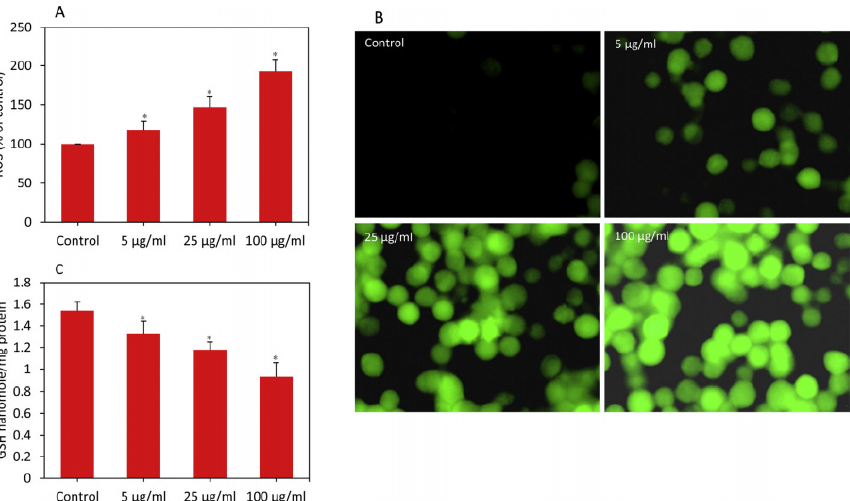
Figure 3. Copper ferrite NP-induced oxidative stress in MCF-7. Cells were exposed to copper ferrite NPs at the dosages of 0, 5, 25, and 100 g/mL for 24 h. At the end of exposure, ROS and GSH levels were determined, as described in materials and methods. ( A ) Percentage change in ROS level. ( B ) Fluorescence microscopy image of ROS generation. ( C ) GSH level. Data represented are mean ± SD of three identical experiments made in three replicates. * Significant difference as compared to control ( p < 0.05).